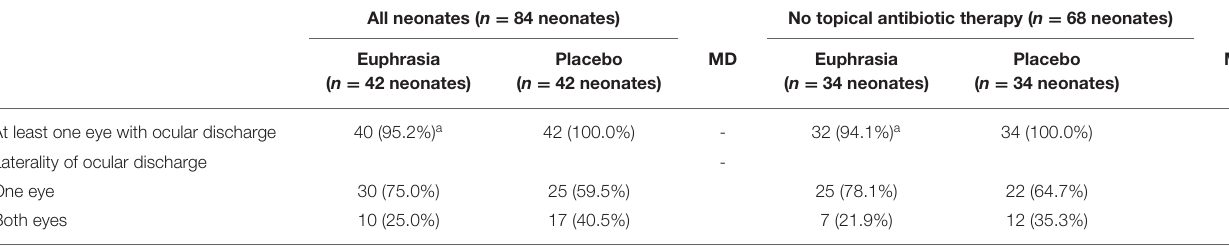
TABLE 2 | Laterality of ocular discharge at baseline according to treatment